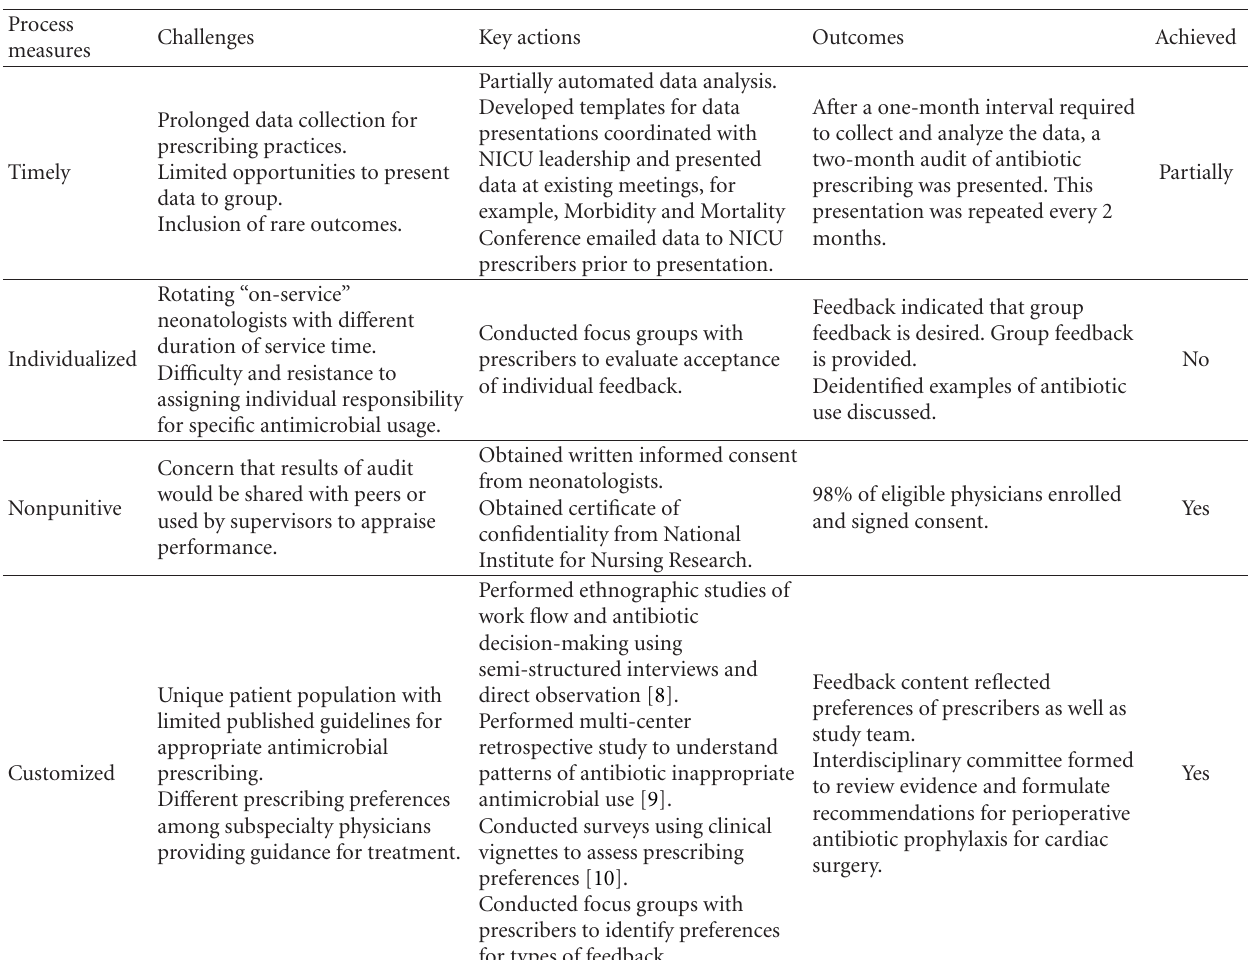
Table 2: Components of actionable feedback for antibiotic prescribing in the